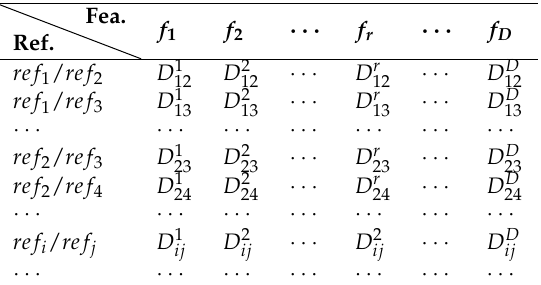
Table 2. Similarity feature vector of each